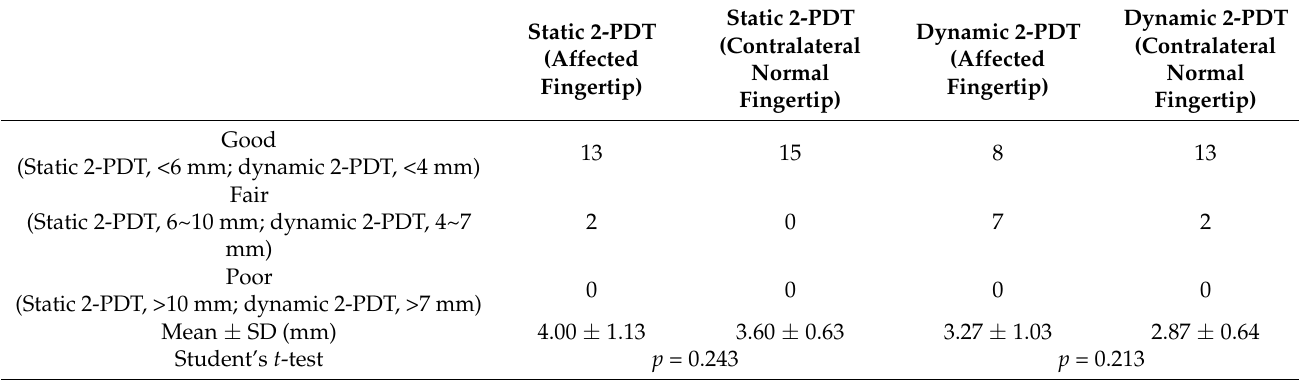
Table 2. Summary of the two-point discrimination test